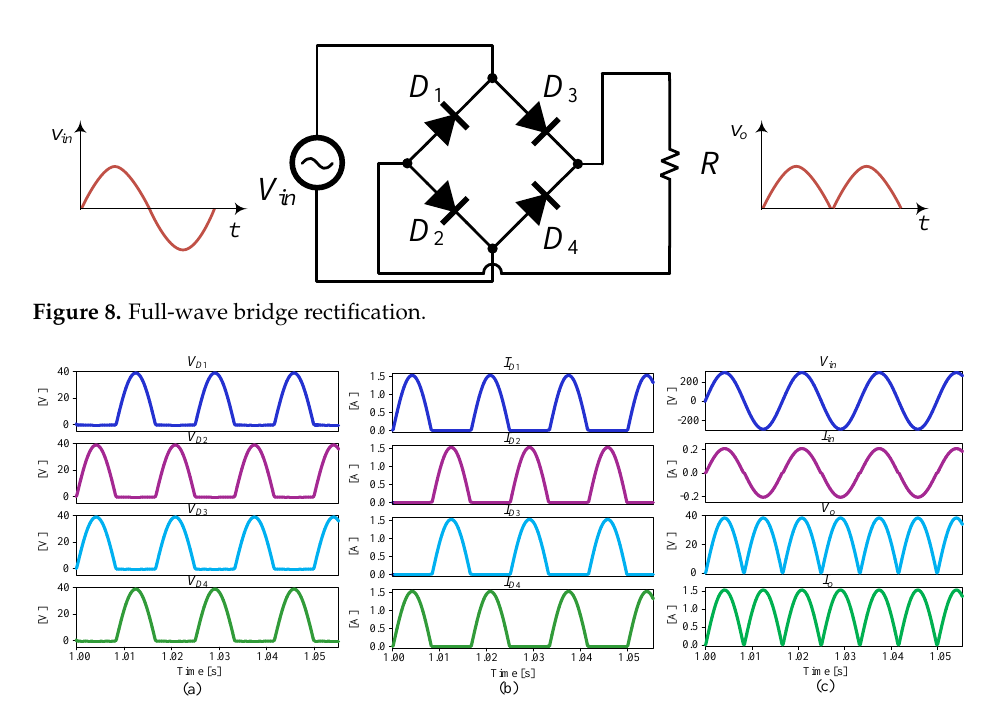
Figure 9. Simulation results of full-wave rectification ( a ) Voltage across the diodes ( b ) currents passing through diodes ( c ) input and output voltages and currents.